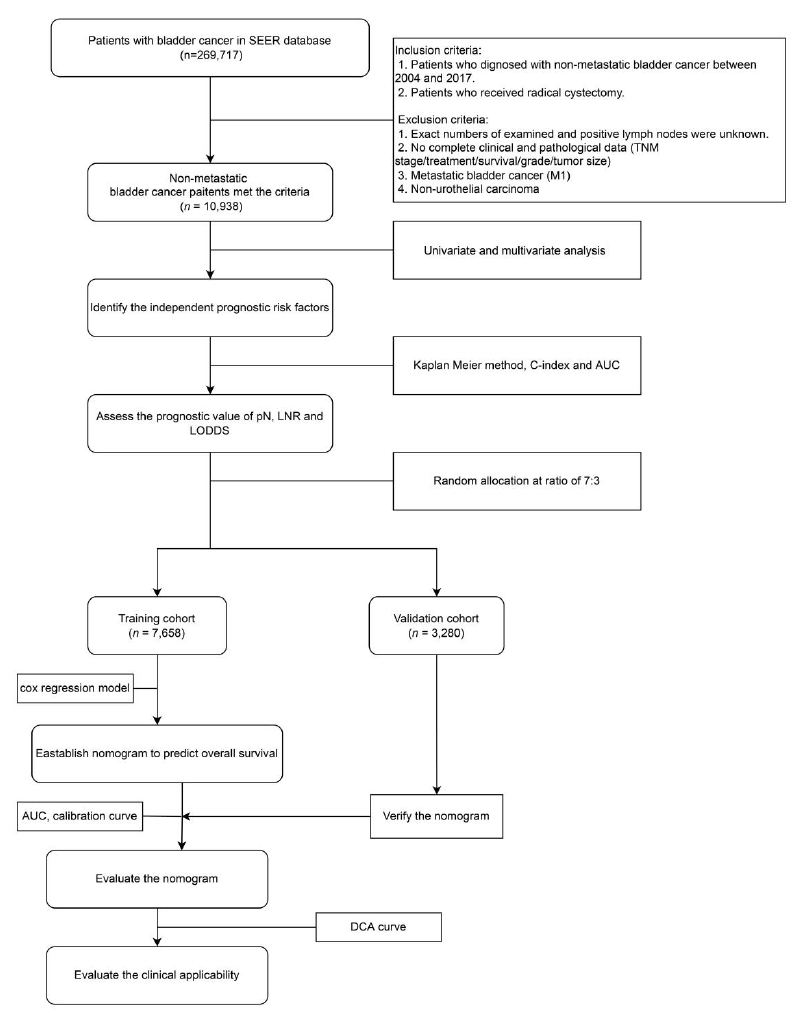
Figure 1. Flow chart of the study. SEER, Surveillance, Epidemiology and End Results; pN: patho- logical N status; LNR: lymph node ratio; LODDS: log odds of positive lymph nodes; AUC: the area under the receiver operating characteristic curve; DCA: decision curve analysis.